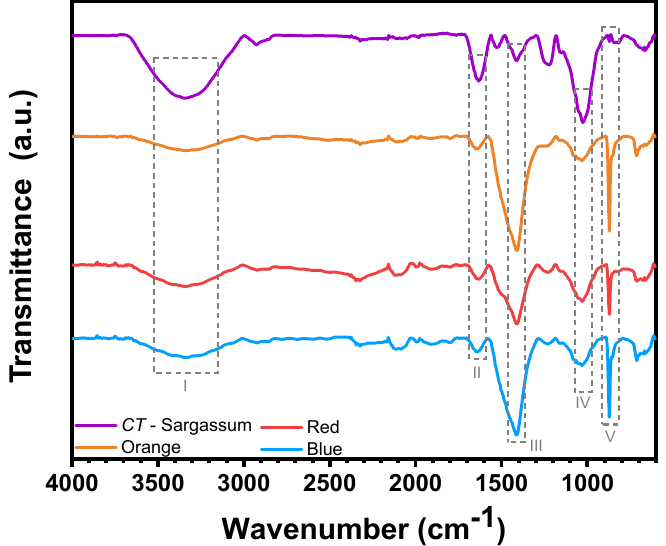
Figure 12. FTIR analysis of CT- Sargassum spp. after filtration. Five different zones of interest are marked by dashed lines (I, II, III, IV and V).